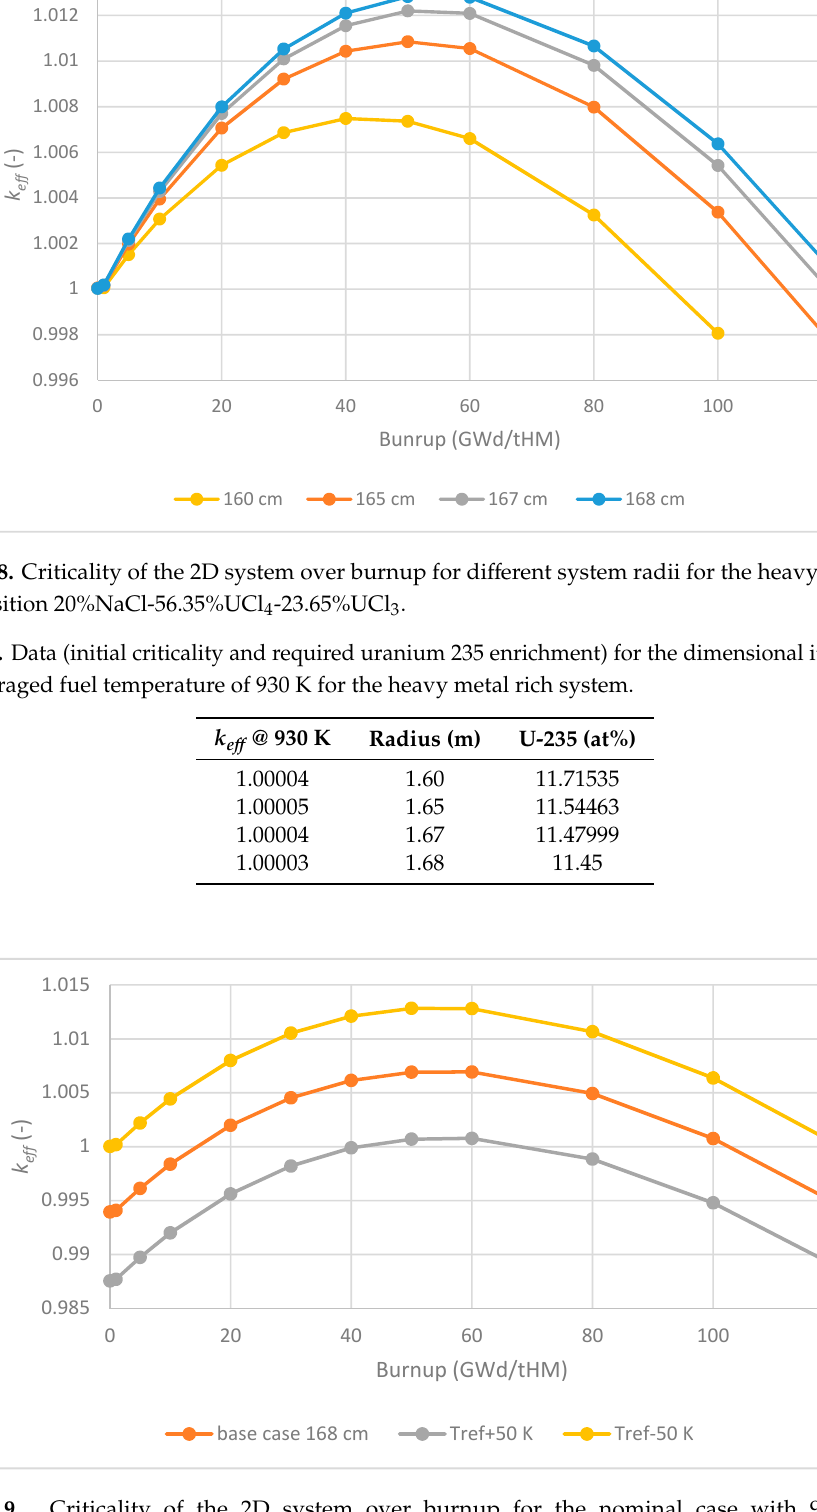
Figure 9. Criticality of the 2D system over burnup for the nominal case with 980 K and cases with reduced and increased system temperature for the heavy metal rich composition 20%NaCl-56.35%UCl 4 -23.65%UCl 3 .